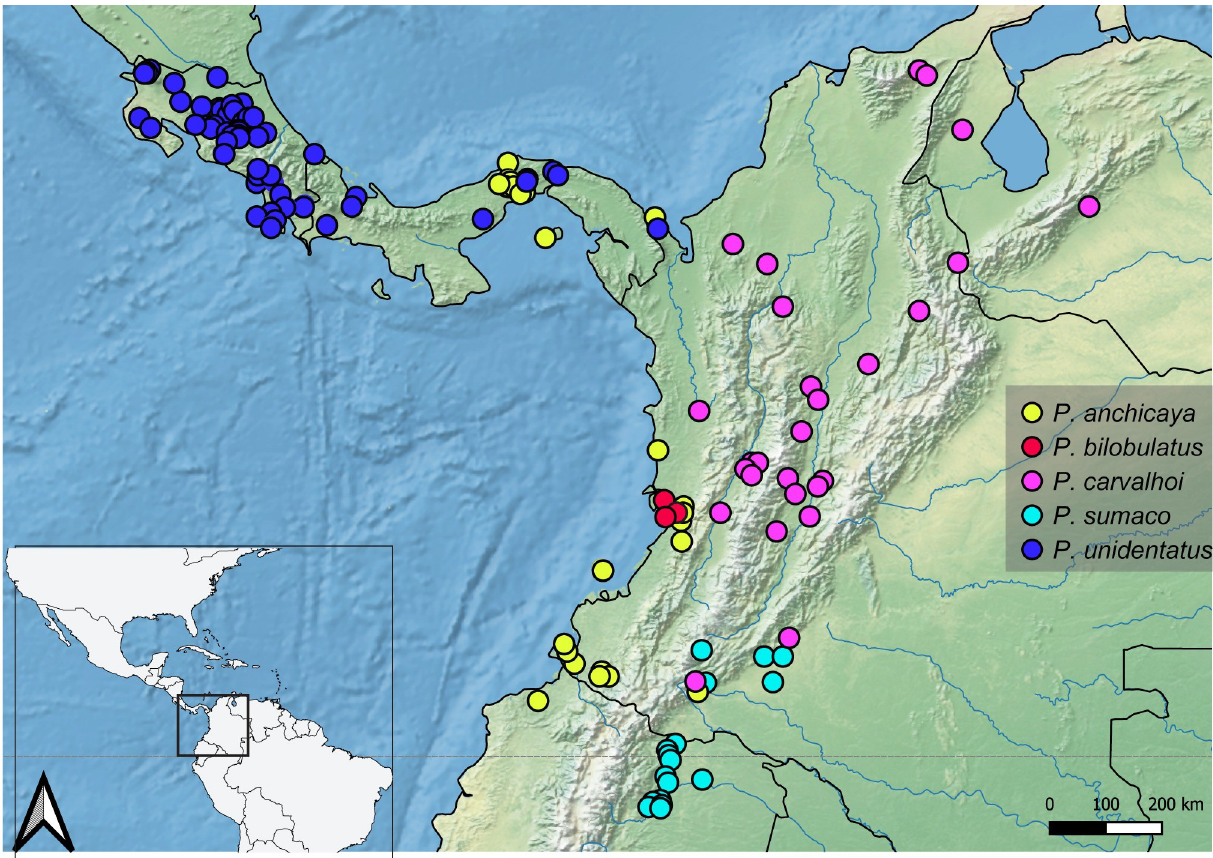
Fig 36. Map showing the geographical distribution of species of P . anchicaya , P . bilobulatus , P . carvalhoi , P . sumaco , P. unidentatus . Spatial data from Natural Earth